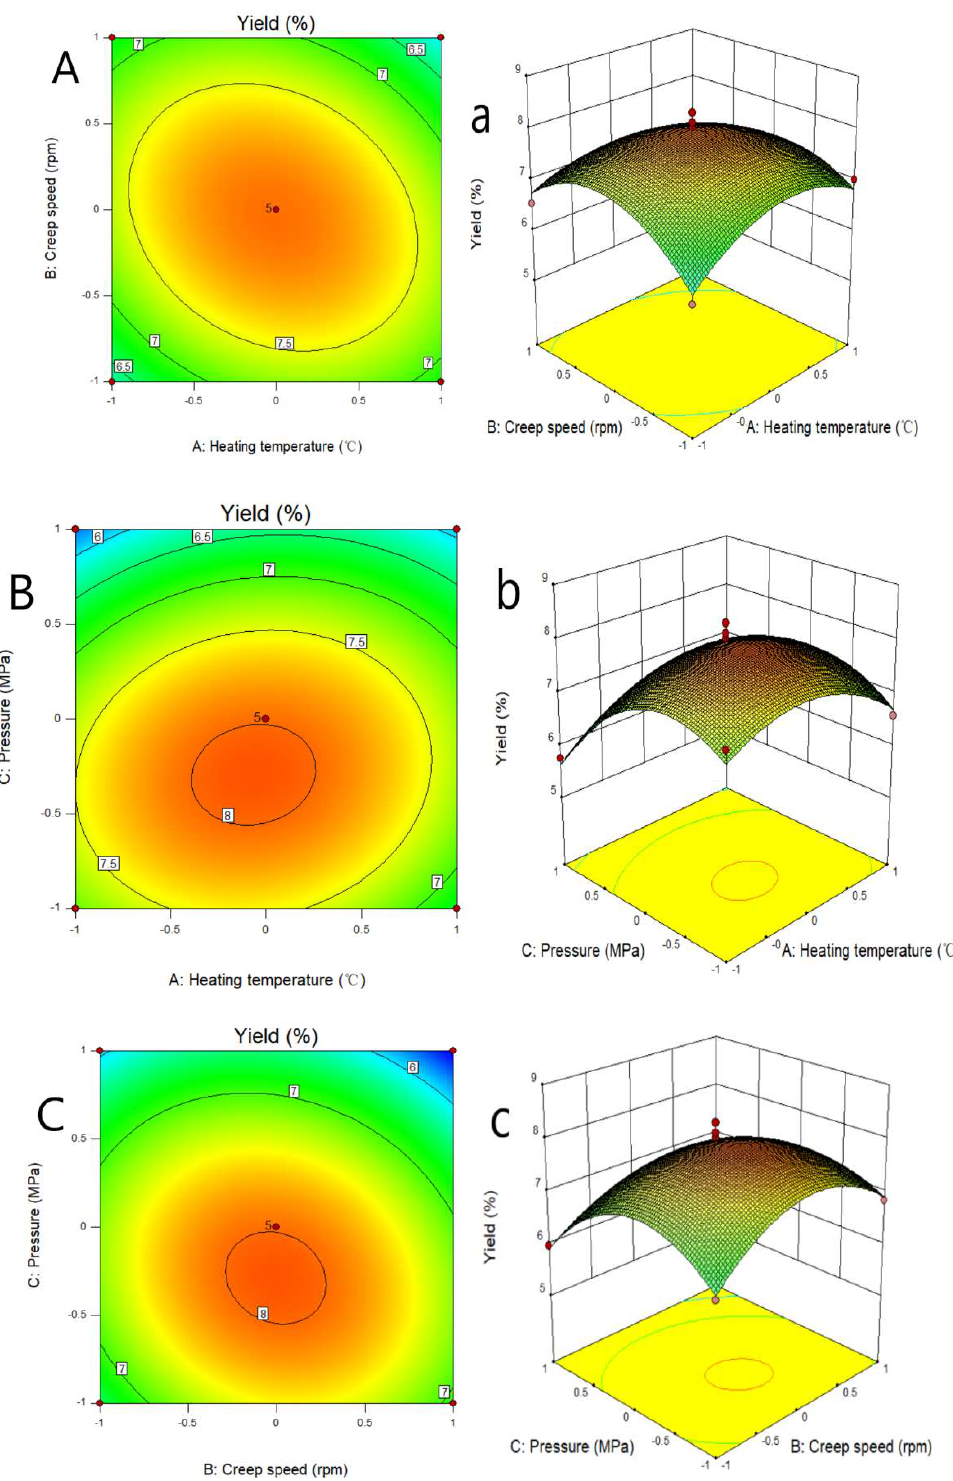
Figure 1. E ff ect of interaction of various factors on inulin Figure 1. Effect of interaction of various factors on inulin yield.